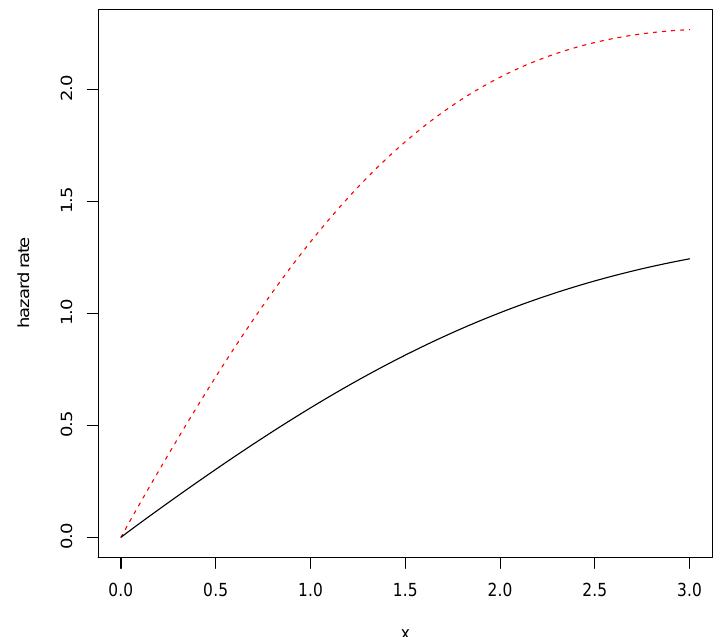
Figure 7. The plots of hazard rate for two stress levels: low stress (solid line) and high stress (dash line). The Bayes estimates based on using domain I are ˜ a 0 = 6.408, ˜ a 1 = − 2.246, ˜ b 0 = 6.397, ˜ b 1 = 2.567, and ˜ c = 2.084; the Bayes estimates via using domain II are ˜ a 0 = 1.966, ˜ a 1 = − 0.913, ˜ b 0 = 1.001, ˜ b = 0.001, and ˜ c = 7.450; and the Bayes estimates based on using domain III are ˜ a 1 ˜ a 1 = − 1.899, ˜ b 0 = 4.164, ˜ b 1 = 1.511, and ˜ c = 3.435. The Markov chains obtained based on